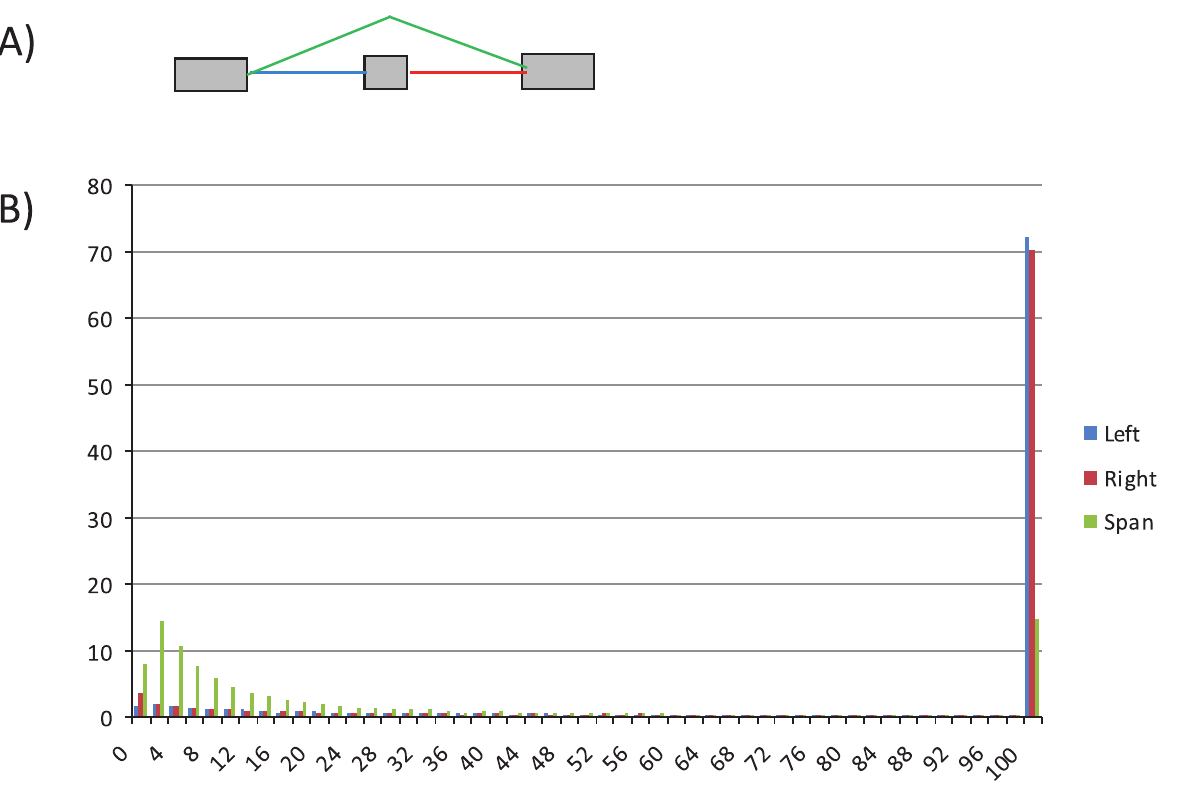
Figure S8. Histograms of reads in the 16 tissue samples supporting the two introns flanking the alternatively spliced exon (blue, red) and the intron spanning the exon (green), respectively, for the 26,989 identified exon skipping events. ( A ) Diagram of an exon skipping event, illustrating the three types of introns: left – blue, right – red, and intron spanning – green. ( B ) Read histograms for the three categories of introns. The x-axis represents the number of supporting reads for an intron, grouped in bins, and the y-axis shows the percentage of introns by levels of supporting reads (in bins). Most events have deep support (>100 reads) for the flanking introns, and to a lesser extent for the spanning intron. Table S9. Summary of novel features by comparison to four annotation databases (CCDS, UCSC Genes, Ensembl v. 61, and H-DBAS). Exon and intron boundaries were compared allowing for a small difference (up to V=0, 5 and 10 bp). Values in bold are those reported in the main